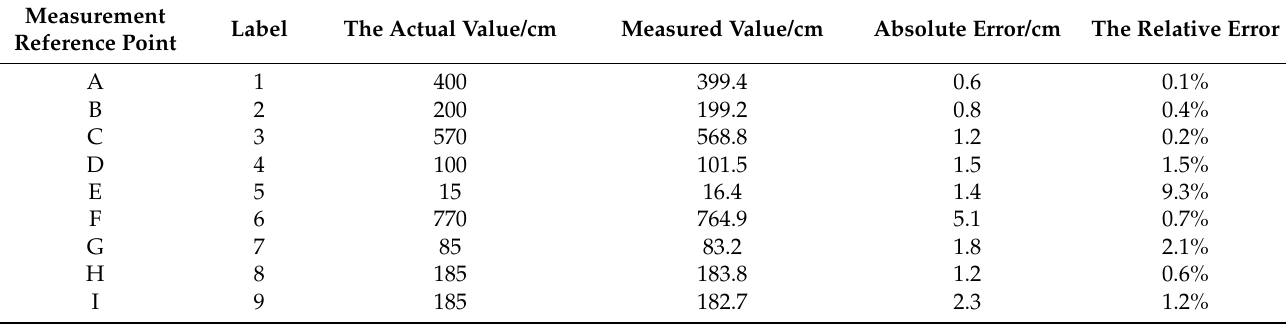
Table 7. Measurement data with a particle count of 60.